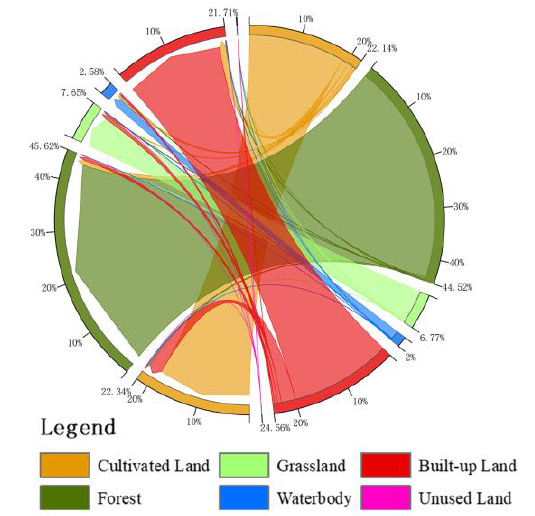
Figure 4. The relationship between land use conversion in 2015-2020(The beginning of the arrow indicates the land proportion in the baseline year, and the arrow points to the land proportion in the target year).